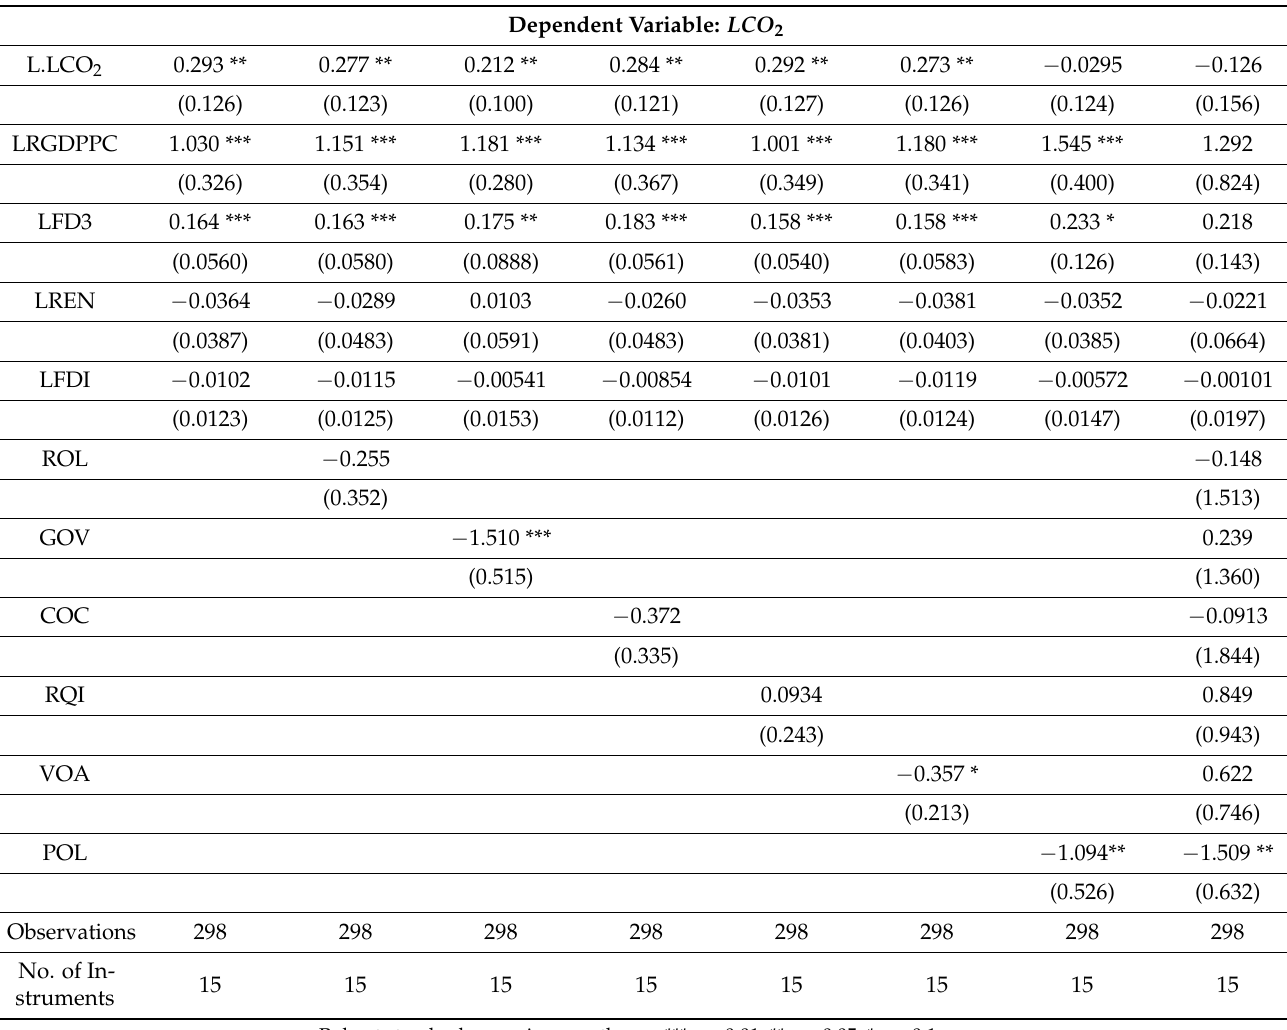
Table 6. Financial development proxied by (iii) domestic credit provided to the private sector by banks (% of GDP) (DCPSB).